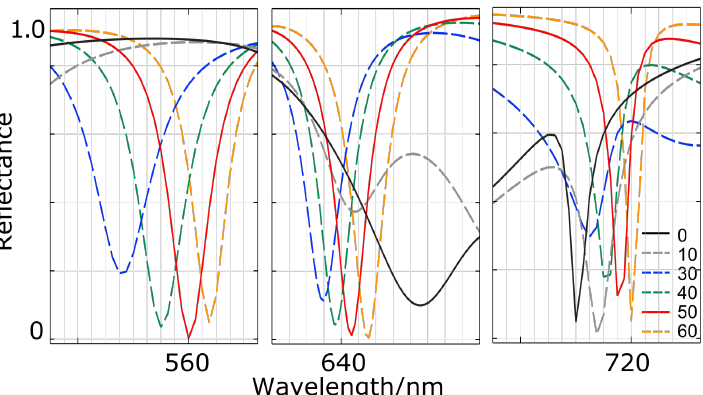
Figure 5. Reflectance spectra against spacer thickness variation (in nanometer) for, from left to right, resonances corresponding at λ 1 , λ 2 , and λ 3 , respectively, in Figure 1.